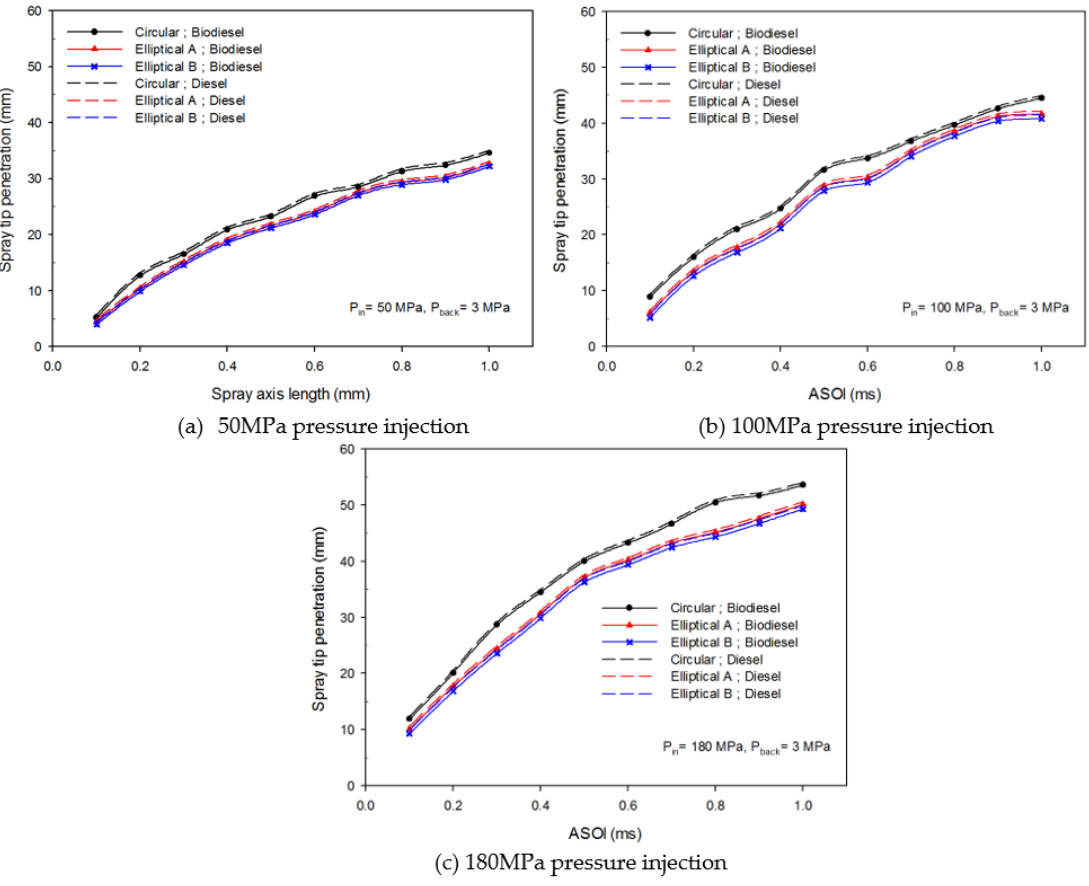
Figure 15. Spray tip penetration under different pressures: ( a ) 50 MPa pressure injection, ( b ) 100 MPa pressure injection, and ( c ) 180 MPa pressure injection.